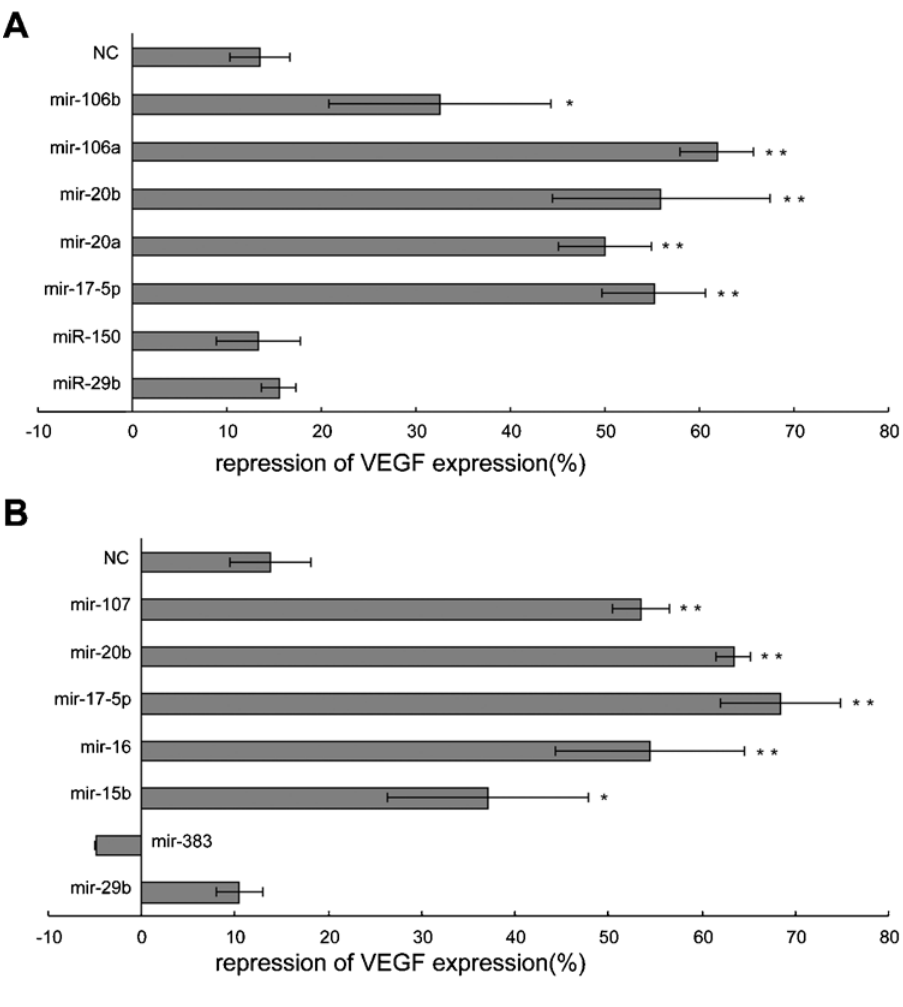
Figure 4. Luciferase activity assay . Luciferase reporter constructs were generated through placing fragments of 185 bp (Construct I, sequence from nt31–216 of the VEGF 3 9 -UTR) and 241 bp (Construct II, sequence from nt703–944 of the VEGF 3 9 -UTR) at the 3 9 end of luciferase gene in pRL-TK. COS-7 cells were co-transfected with a luciferase reporter vector and an miRNA which has a putative binding site in either Construct I (A) or Construct II (B). Luciferase activity was measured to determine the effects of these miRNAs on luciferase translation. In addition to a random sequence (NC), miR-29, miR-150 , and miR-383 which have putative binding sites in the 3 9 -UTR of VEGF but not on Construct I or II, as predicted by all of the algorithms, were employed as negative controls. *, p , 0.05; **, p ,